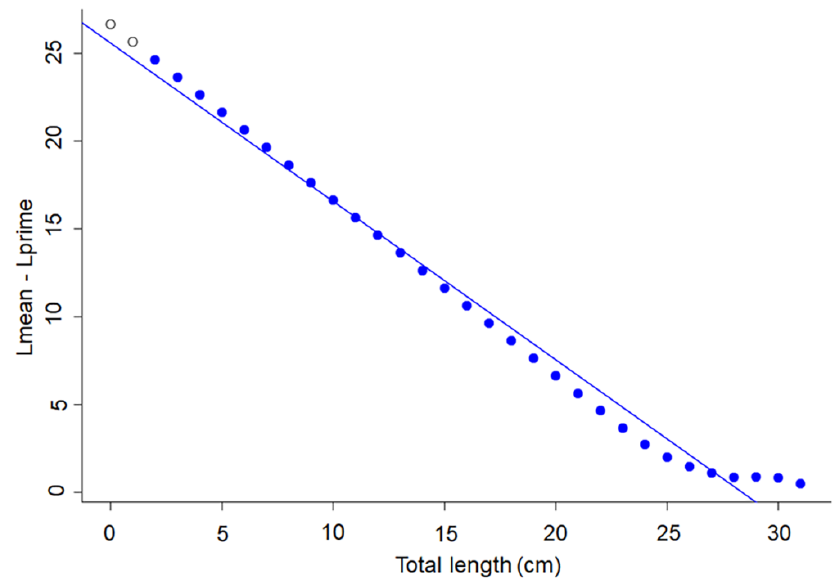
Figure 2. Powell – Wetherall plot to derive an estimate of L ∞ for Sardina pilchardus in Northern Senegalese waters. L mean is the mean length of the cohort; L prime is any length equal and above the length under full exploitation. The regression line identifies the first length at full exploitation, coinciding with the largest size grouping in the length-frequency data (blue circle).